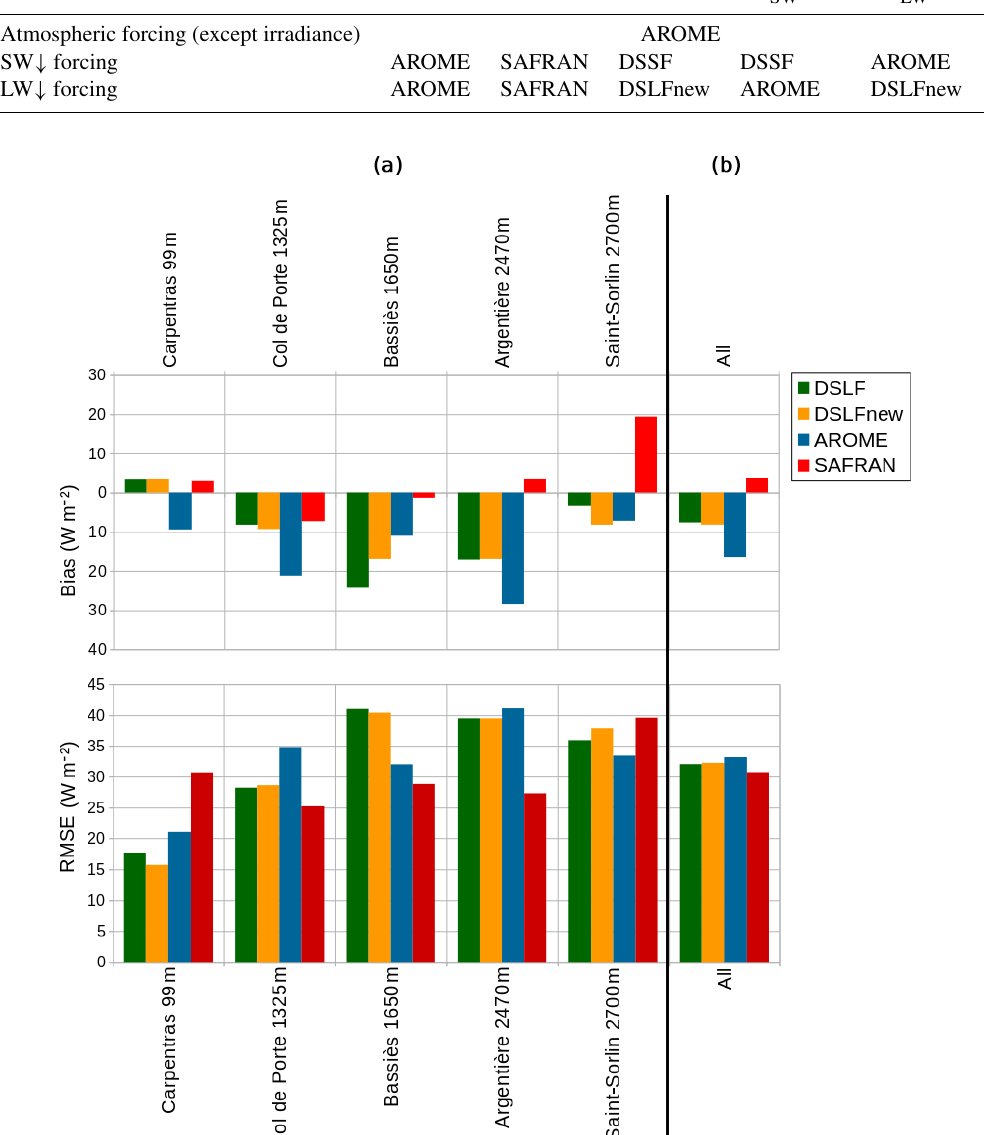
Figure 3. Bias and RMSE of LW ↓ irradiance products (DSLF in green, DSLFnew in orange, AROME in blue, SAFRAN in red) compared to each station (a) and all stations (b)